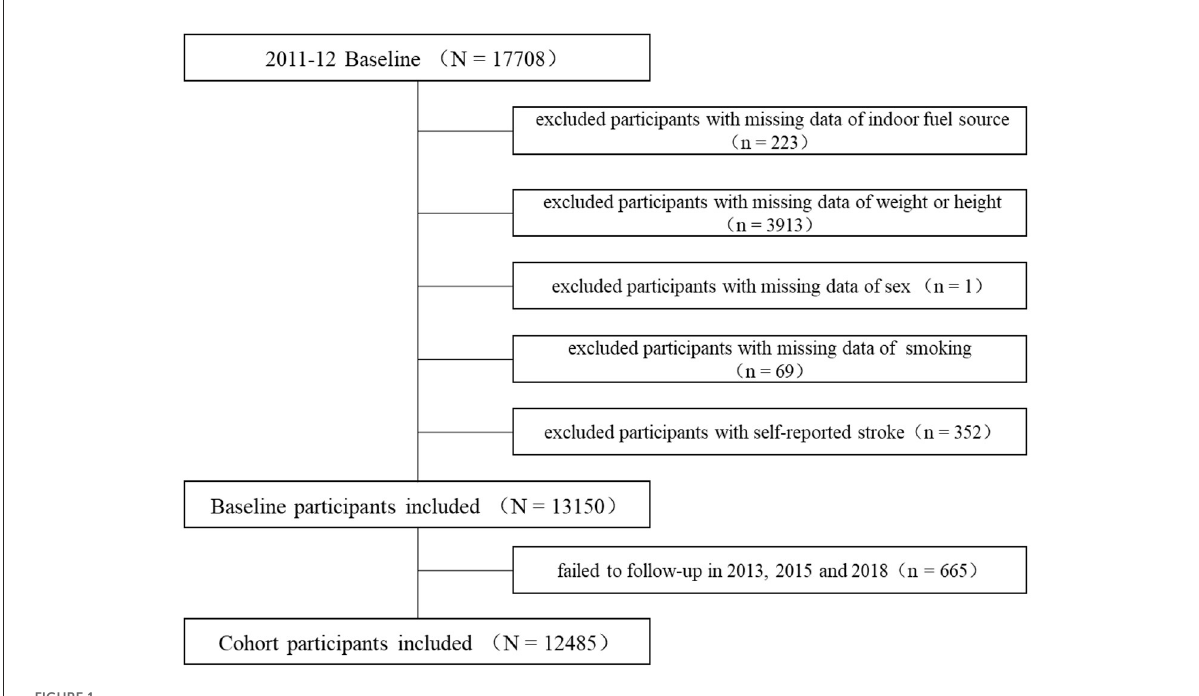
FIGURE1 Participant-selection